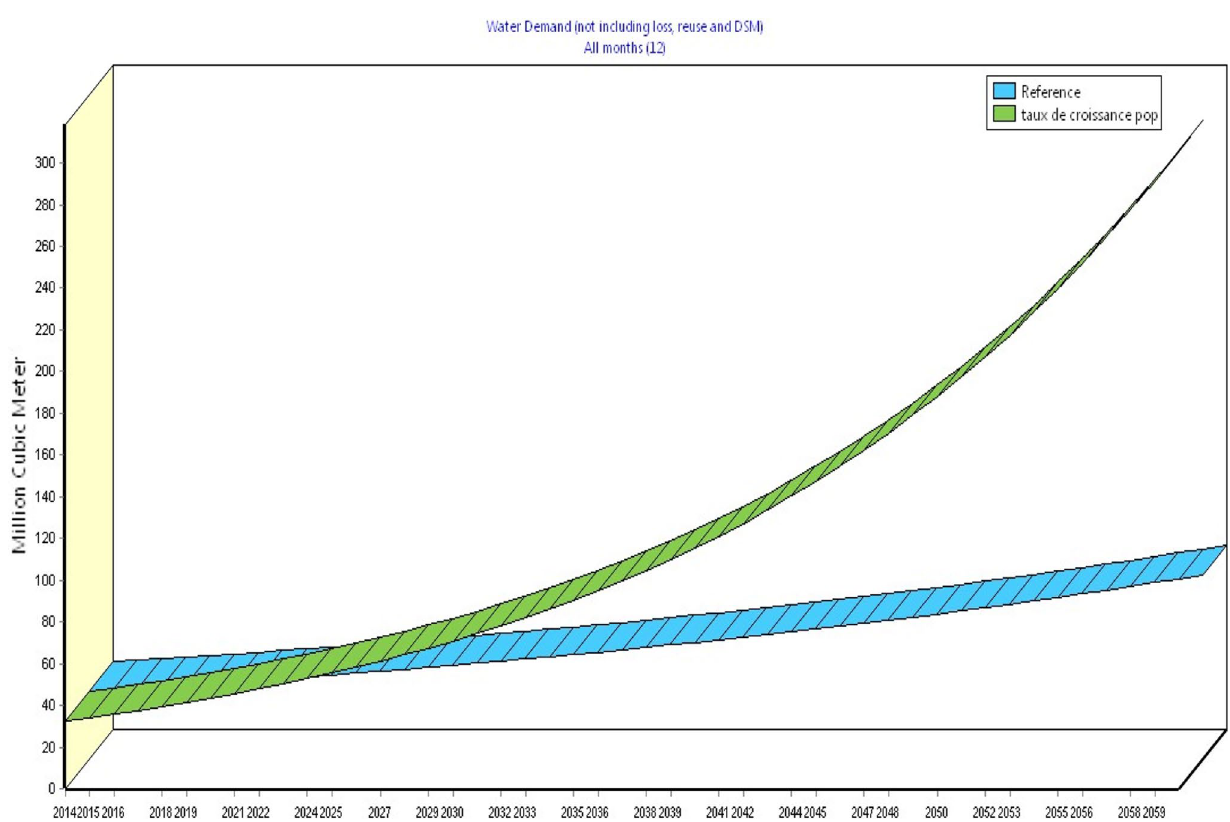
Fig. 7 Evolution of water demand in Bechar city—all scenarios; source: own